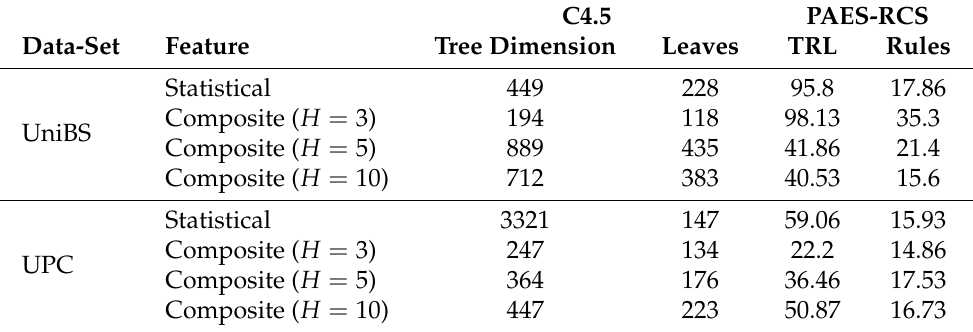
Table 20. Performance comparison: Complexity (for the PAES-RCS algorithm the First solution has been